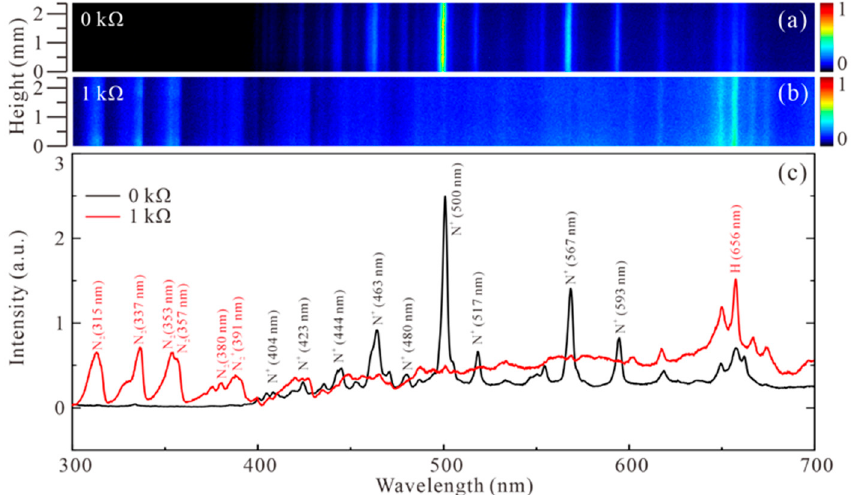
Figure 12. Emission spectra from the filamentary column of different plasmas collected with spectrometer slit, vertically orientated perpendicular to the thin plasma columns. ( a ) Imaging spectra of FALED with a resistance of 0 k Ω ; ( b ) Imaging spectra of FALED along the jet flow with a resistance of 1 k Ω ; ( c ) Spectral curve of emission from the filamentary plasma with the resistances of 0 k Ω (black line) and 1 k Ω (red line) .